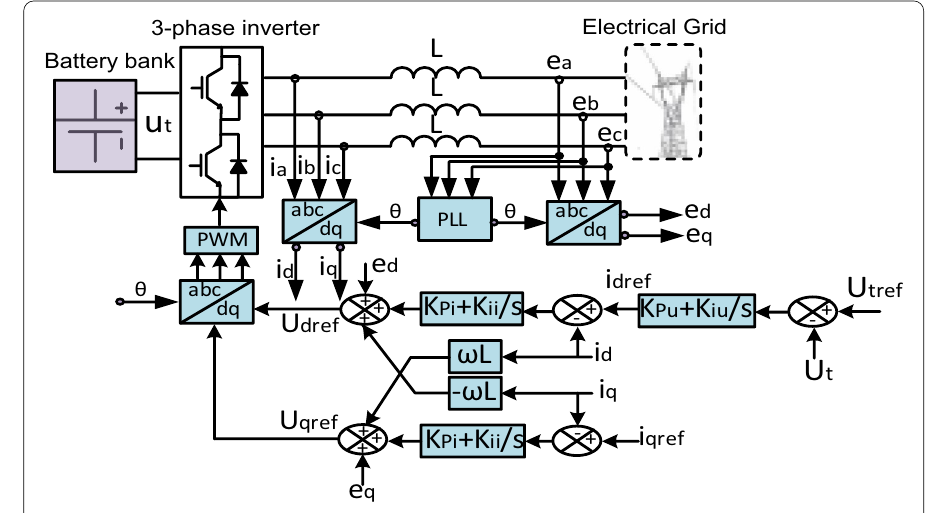
Fig. 4 PI controller structure synchronous reference frame for the employed